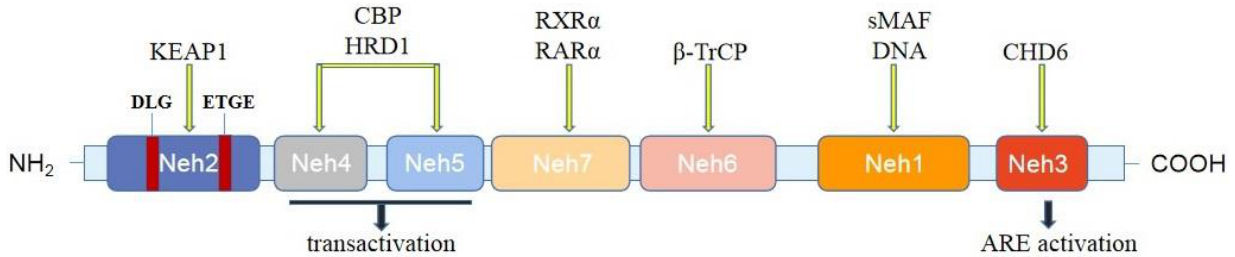
Figure 1. Domain structures of Nrf2. The Nrf2 protein contains seven domains: Neh1–Neh7. Neh2 is the Keap1-binding domain. Neh4, 5, and 3 domains are critical for transactivation. Neh3 can activate transcription of downstream-related genes. The Neh6 region participates in the Keap1 alternative degradation pathway. The Neh1 region binds to small musculoaponeurotic fibrosarcoma (sMaf) and forms a heterodimer. Neh7 can bind to RXR α and RaR α . KEAP1, cytoplasmic kelch-like epichlorohydrin-associated protein 1; CBP, cyclic AMP response element-binding protein; HRD1, HMG-CoA reductase degradation protein 1; RXR α , retinoid X receptor α ; RAR α , retinoic acid receptor α ; β -TrCP, β -transducin repeat-containing protein; sMAF, small musculoaponeurotic fibrosarcoma; CHD6, chromodomain helicase DNA-binding protein 6; ARE, antioxidant response element.